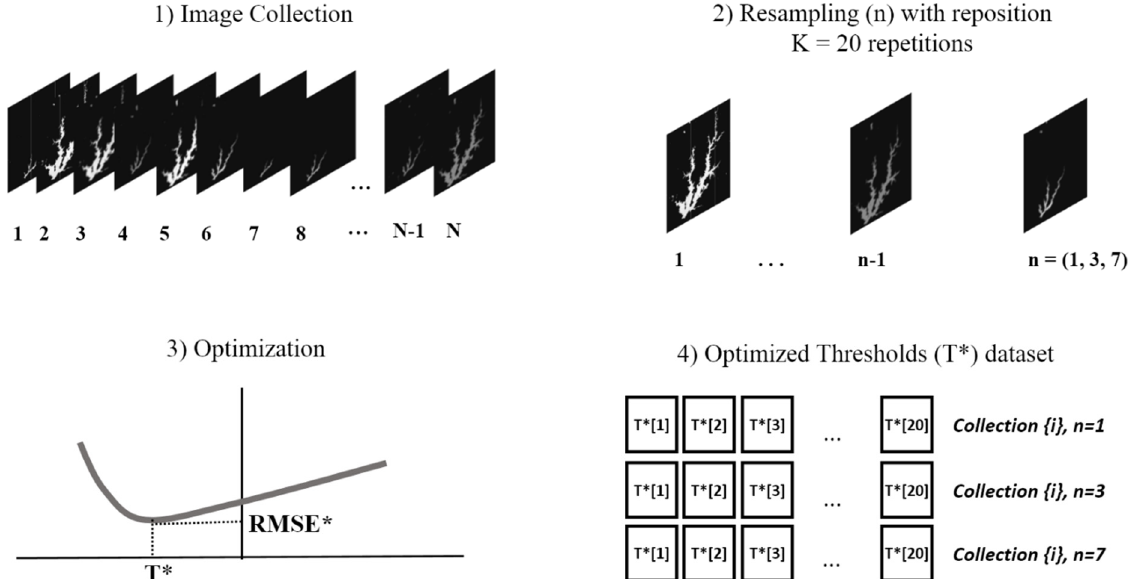
Figure 4. Optimized thresholds generation: (1) The original Landsat-8 (N = 19) and Sentinel-2 (N = 24) images data is assumed to be the population; (2) n = (1,3,7) images are drawn randomly from the population with reposition; (3) the optimization process described above and illustrated in Figure 3 is run to obtain T* as output, and the sampled images in the former step as input; (4) the process is repeated 20 times for each image collection and each sample size n = (1,3,7).